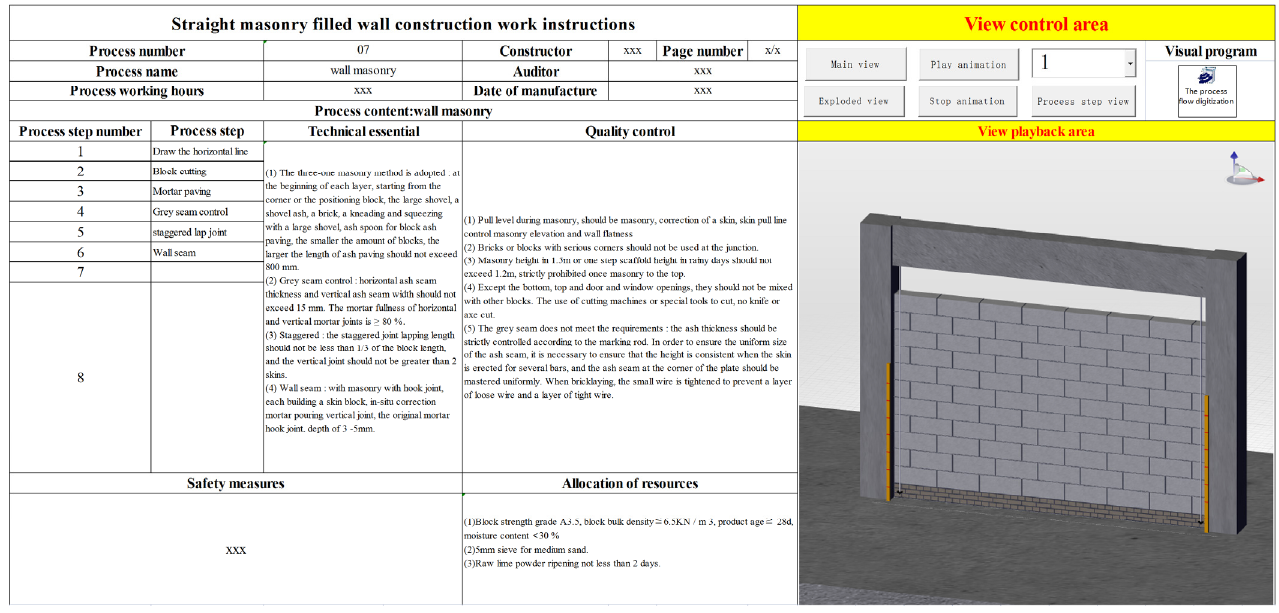
Figure 10. Infill wall masonry construction